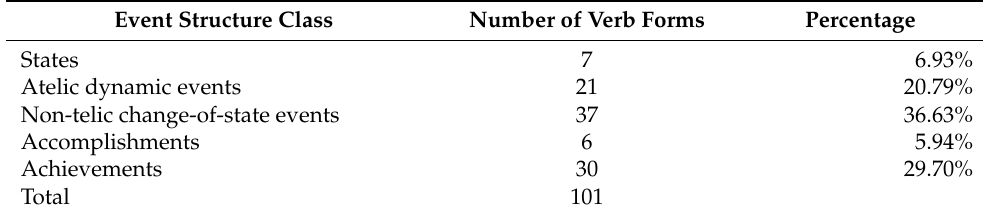
Table 6. Event structure classes in our sub-corpus of past-inflected